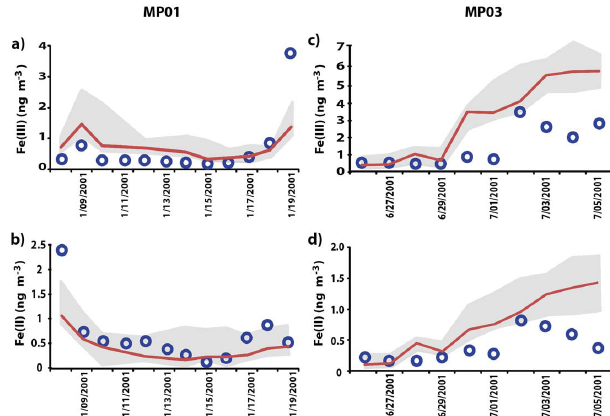
Fig. 6. Daily averaged baseline model-predicted (red line) and ob- served (blue open circles) surface level concentrations of (a, c) Fe(III) (ngm − 3 ) and (b, d) Fe(II) (ngm − 3 ) from 8 January to 19 January 2001 (MP01) – left column – and from 26 June to 5 July 2001 (MP03) – right column. The shaded area illustrates the range of model-predicted Fe(II)/Fe(III) concentrations when as- suming illite and goethite as the major Fe-containing mineral within dust. Model-predicted concentrations are from the first model grid above the ocean